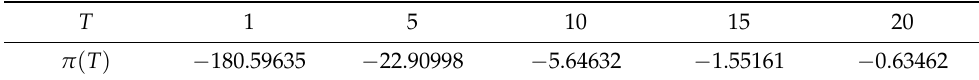
Table 3. Related profits for Example